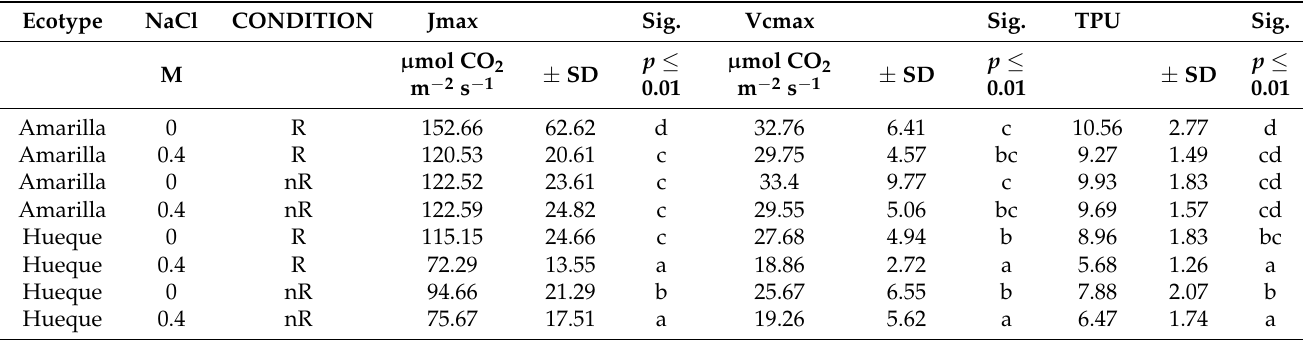
Table 5. The effect of salinity on the main photosynthetic parameters of tolerant and sensitive ecotypes of quinoa using the model of Farquhar et al. (1980).